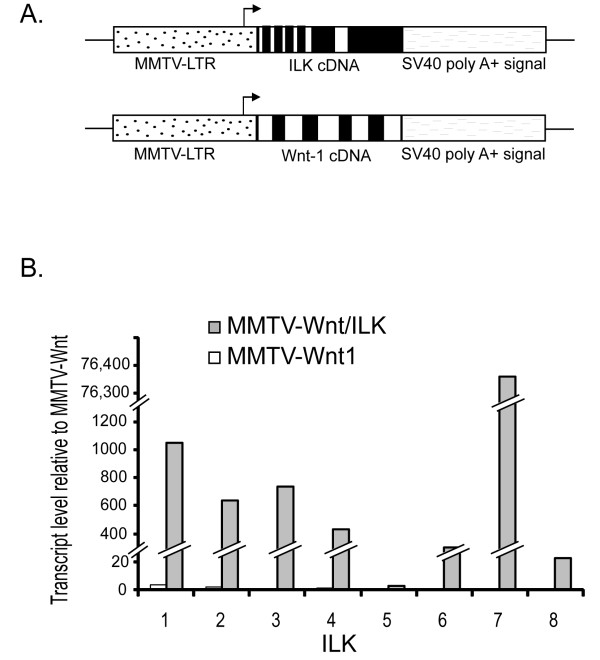
Overexpression of the human ILK gene. (a) Mouse MMTV-Wnt1 and human MMTV-ILK transgene constructs (b). Quantitative RT-PCR performed on randomly selected tumors from each MMTV-Wnt1 and MMTV-Wnt/ILK group (n = 8) showing a dramatic overexpression of the human ILK gene in the double-transgenic samples. The bar graphs show the relative amount of human ILK overexpression in the individual MMTV-Wnt/ILK and MMTV-Wnt1 tumors normalized for β-actin expression. The statistical analysis with 95% confidence interval of (+754.18; -256.46) shows an average value of about 400-fold of overexpression in human ILK in MMTV-Wnt/ILK with an adjusted P value of 3.1E-16 determined by Benjamini-Hochberg test.